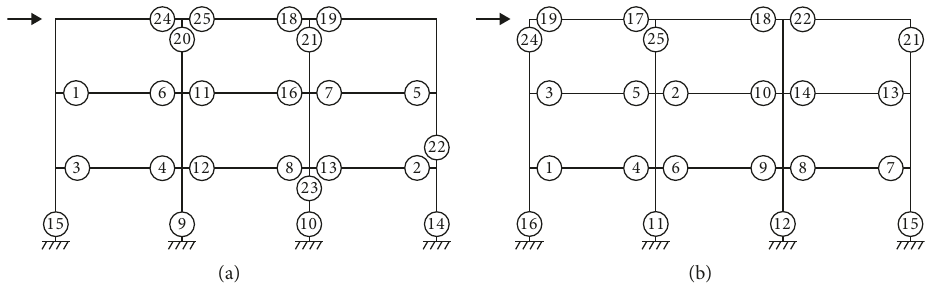
Figure 11: Sequence and position of plastic hinges in test specimens. (a) KJ-1. (b)